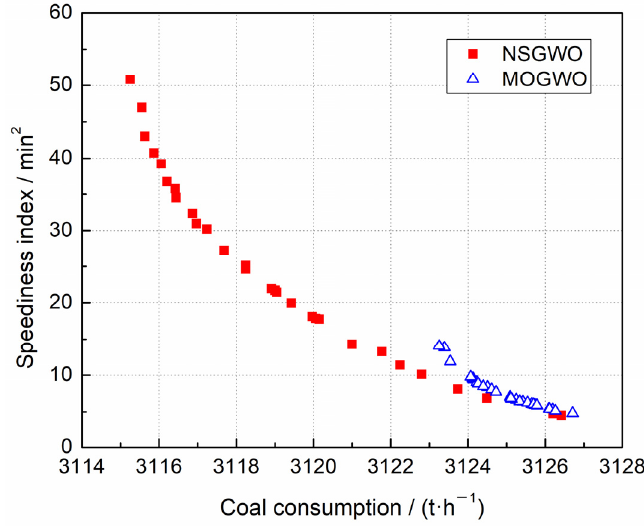
Figure 5. Pareto fronts of coal consumption and speediness index of load-dispatch optimization for 10 units with various power scales under NSGWO and MOGWO algorithms.